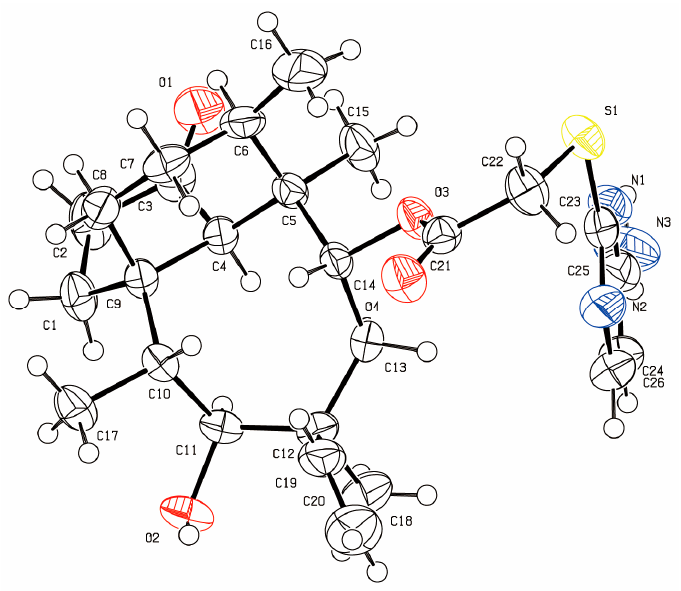
Figure 2. Oak Ridge Thermal-Ellipsoid Plot Program (ORTEP) diagram for compound 3a with ellipsoids ellipsoids set at 75% set at 75% probability.